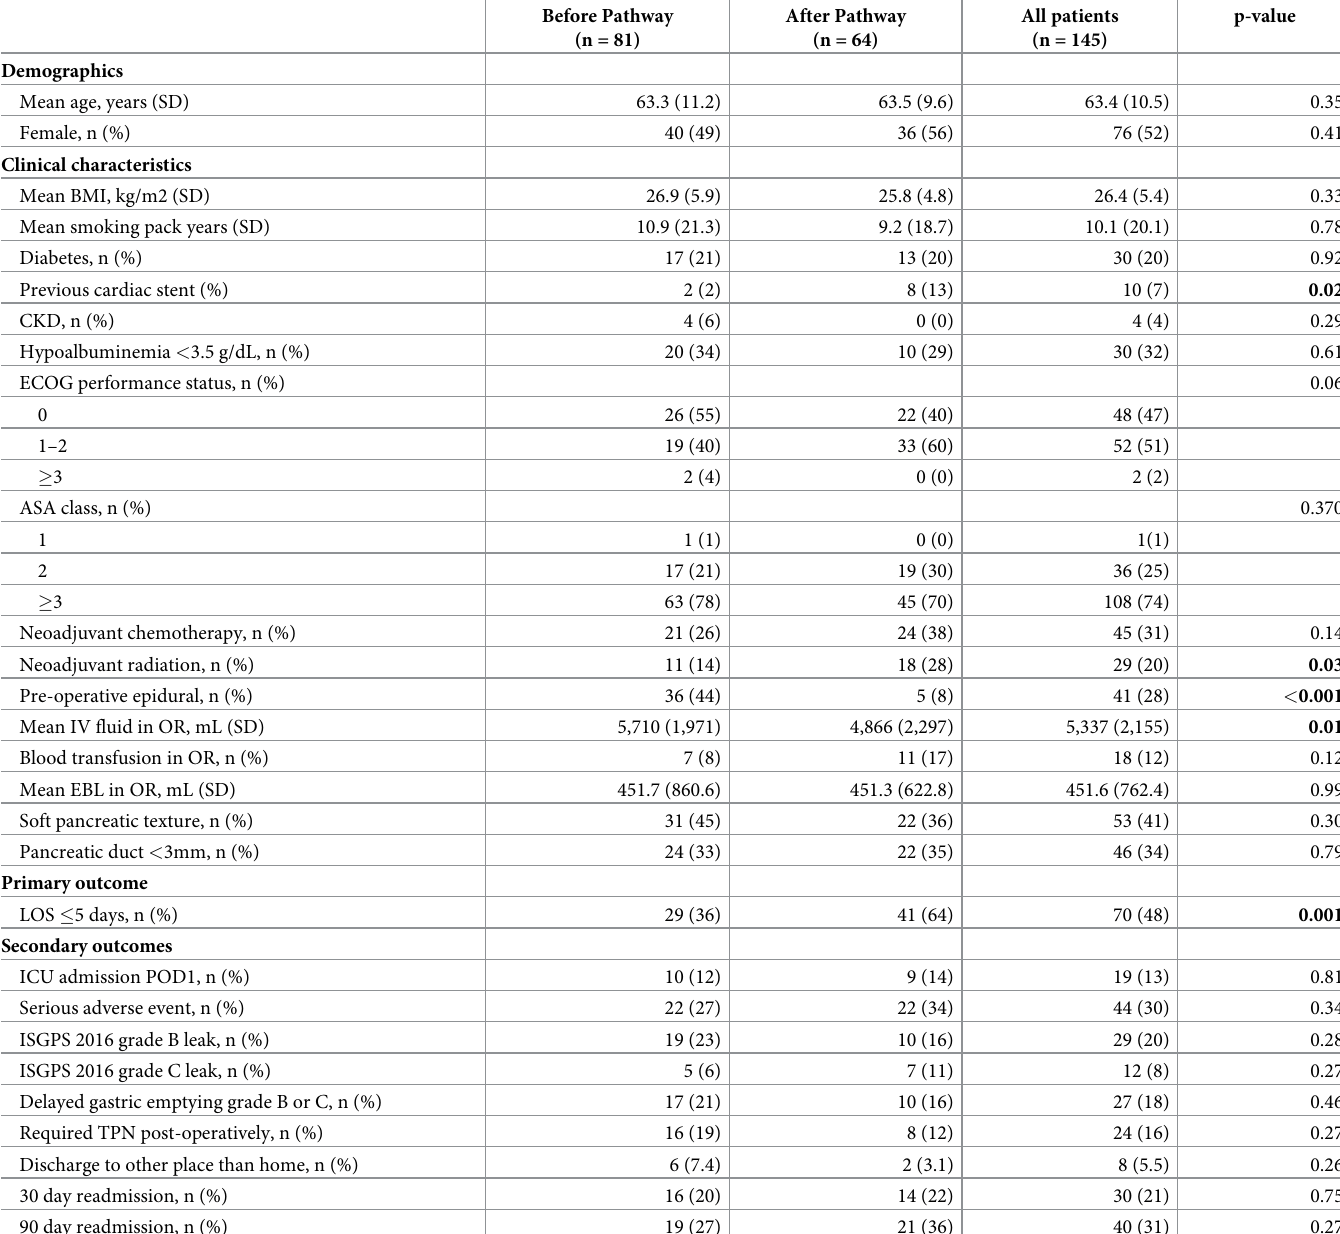
Table 1. Demographics, clinical characteristics, and outcomes of patients before and after PD pathway implementation.